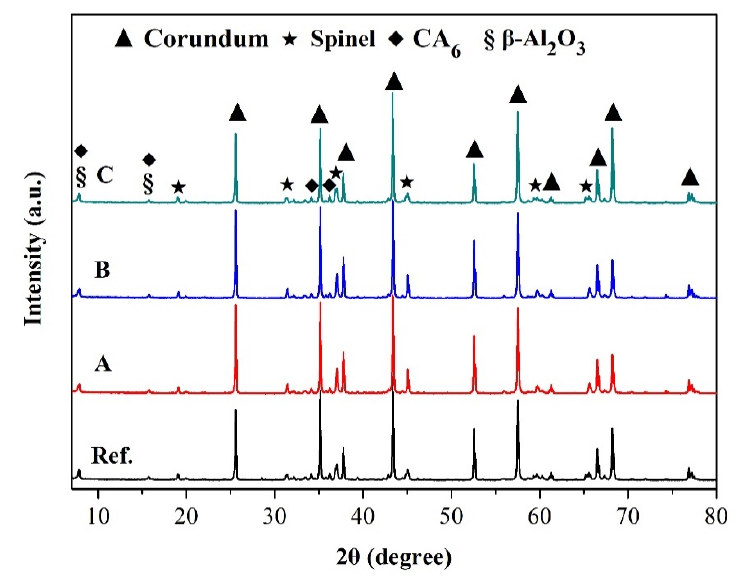
Figure 2. XRD patterns of castables after firing at 1550 °C for 3